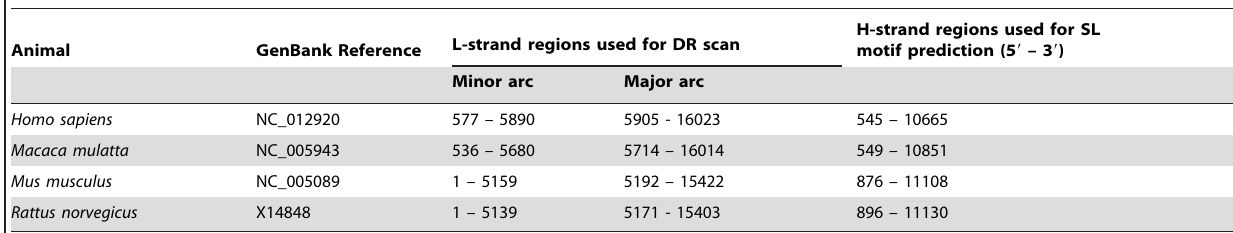
Table 3. Mitochondrial genome sequence